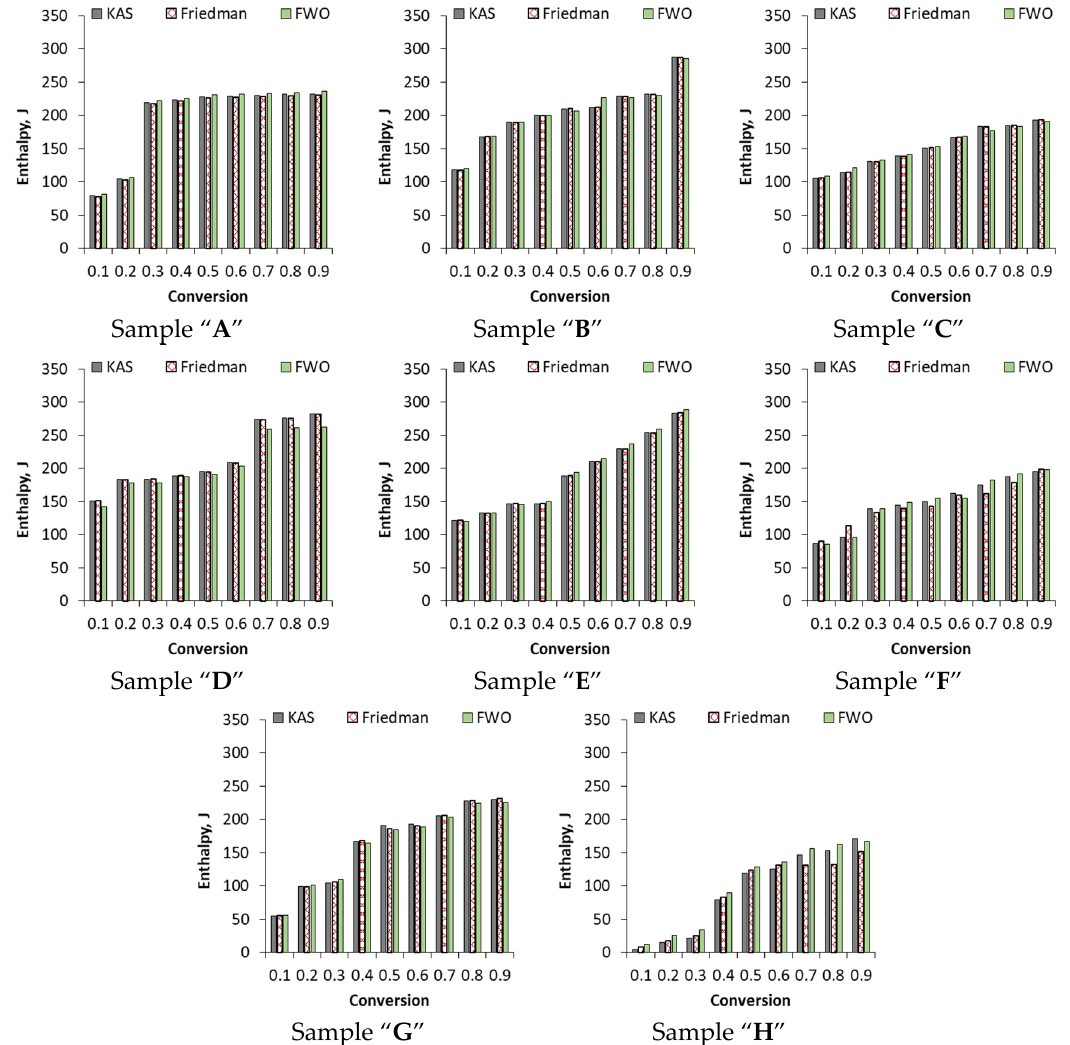
Figure 8. Enthalpies calculated by the KAS, Friedman and FWO methods.